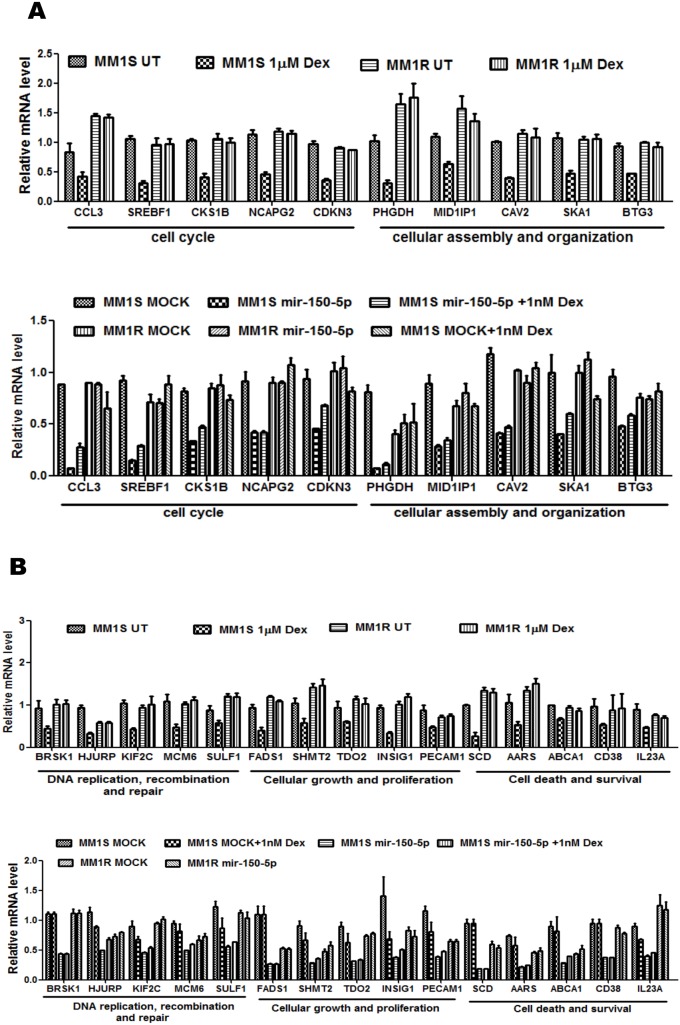
Mir-150-5p specific mRNA changes in MM1S are associated with pathways related to cell death and survival, cell cycle, cellular growth and proliferation (A–B)mir-150-5p specific mRNA regulation of the genes involved in (i) cell cycle, (ii) cellular assembly and organization, (iii) DNA replication, recombination and repair, (iv) cell growth and proliferation, (v) cell death and survival. Illumina BeadChip Gene Expression Array results are presented as bar graphs, reflecting mean of gene expression fold change from three independent experiments of MM1S cells, treated for 72 h with 1 µM Dex vs control cells (upper panels A–B), or else of MM1S cells transfected for 72 h with synthetic mir-150-5p versus mock transfection, treated for 72 h with 1 nM Dex or a combination thereof versus control samples (lower panels A–B).